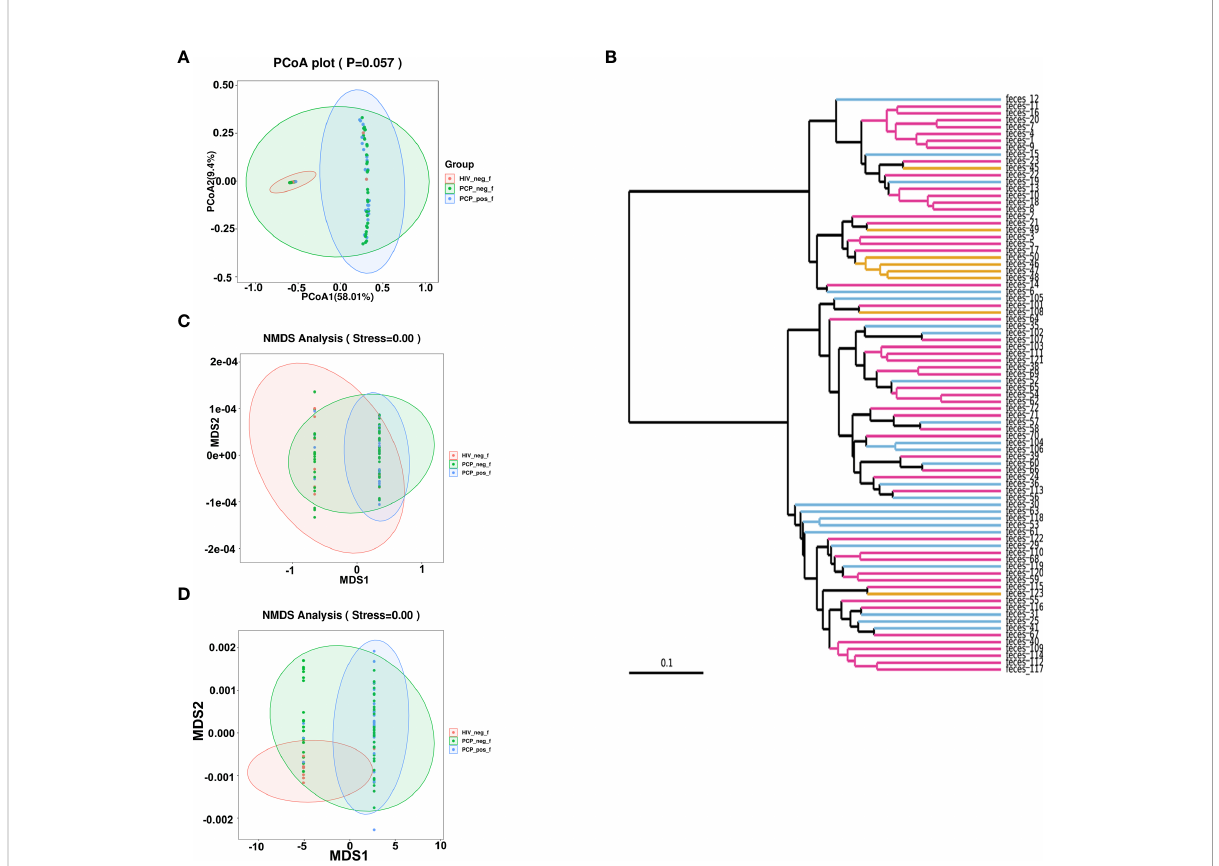
FIGURE 2 b -diversity analyses of fecal microbiomes of HIV+PCP+ group (PCP_pos_f), HIV+PCP- group (PCP_neg_f), and HIV- group (HIV_neg_f). The diversity of the samples was analyzed by (A) Principal coordinates analysis (PCoA) plot (unweighted_unifrac_pcoa). (B) Unweighted Pair Group Method with Arithmetic Mean (UPGMA) (unweighted_unifrac_feature). (C) Non-metric multidimensional scaling (NMDS) analysis (unweighted_unifrac_NMDS). (D) NMDS (weighted_unifrac_NMDS)